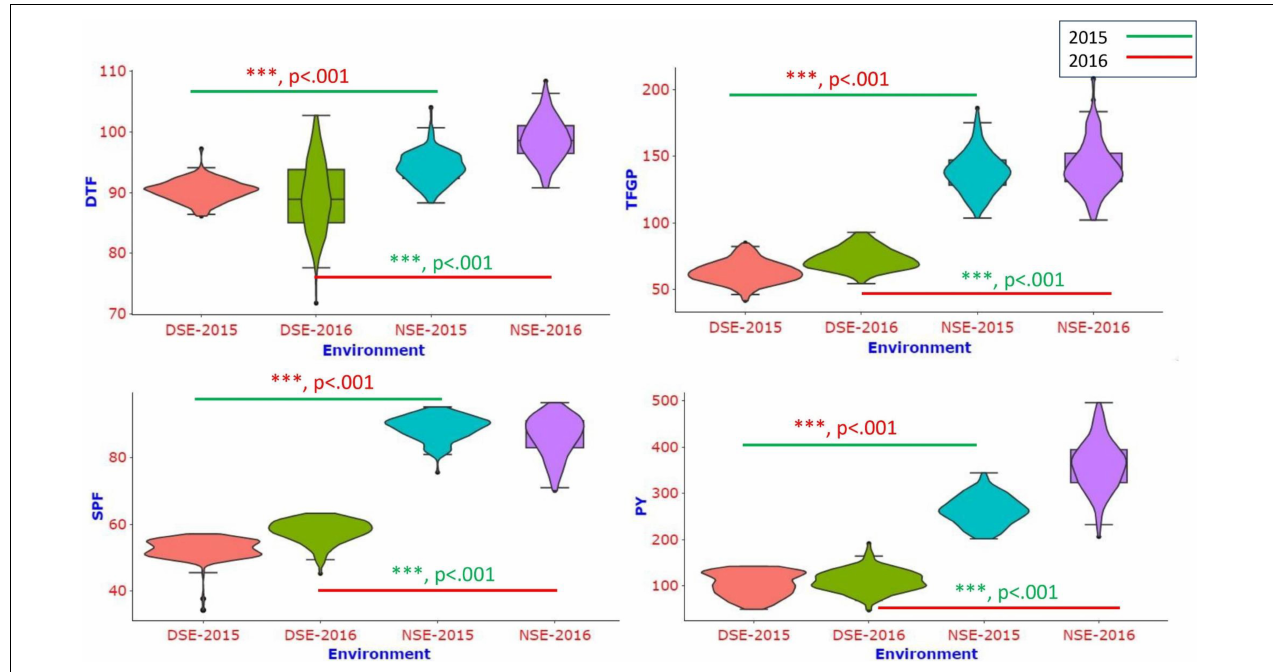
FIGURE 2 | The violin plot shows the phenotypic distribution of DTF, TFGP, SPF% and PY traits in the population in different